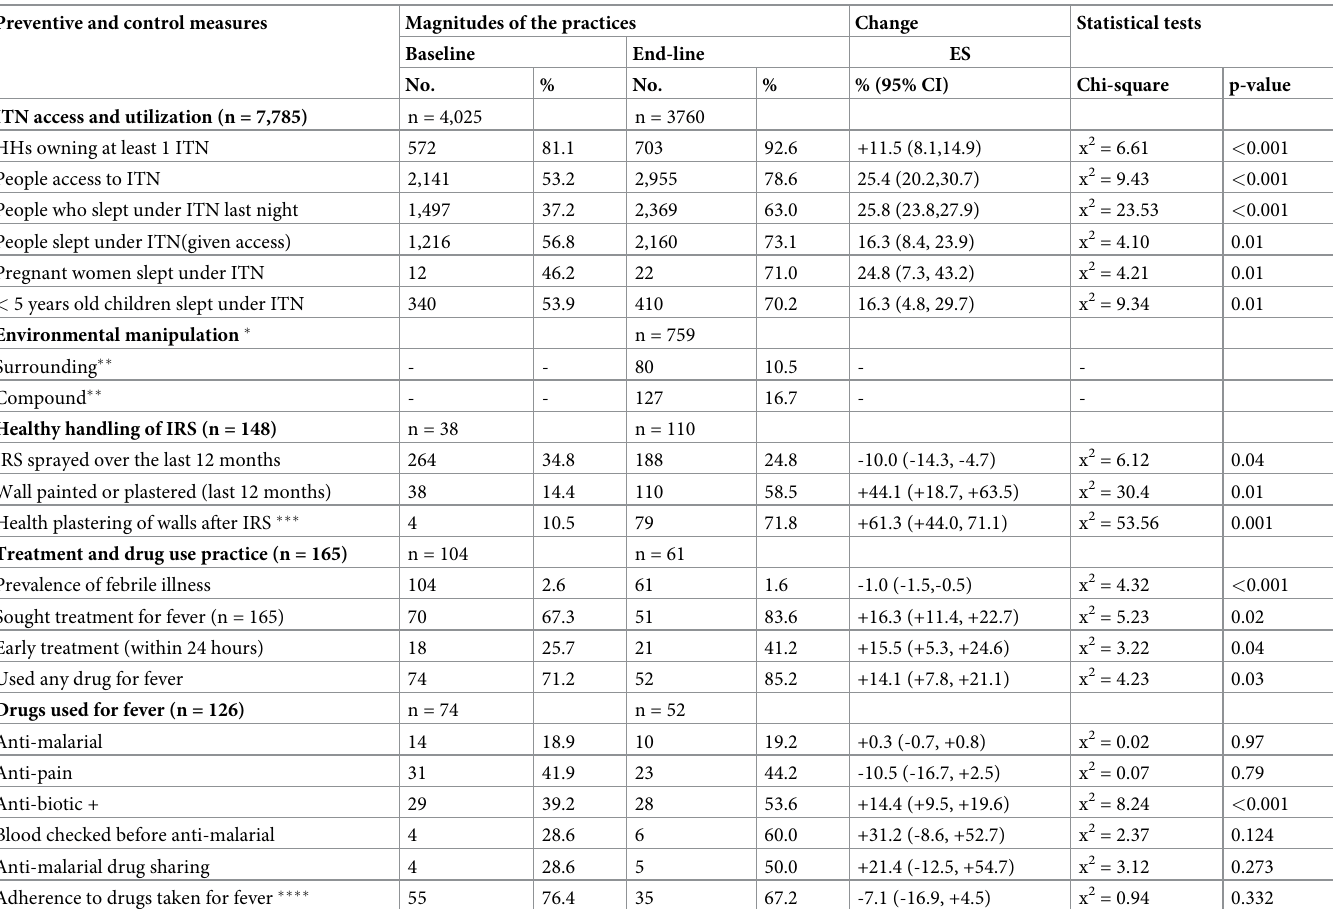
Table 6. Change community malaria preventive and control practices, Jimma Zone, SBCC target districts, 2017–19 (Baseline = 762; End-line =